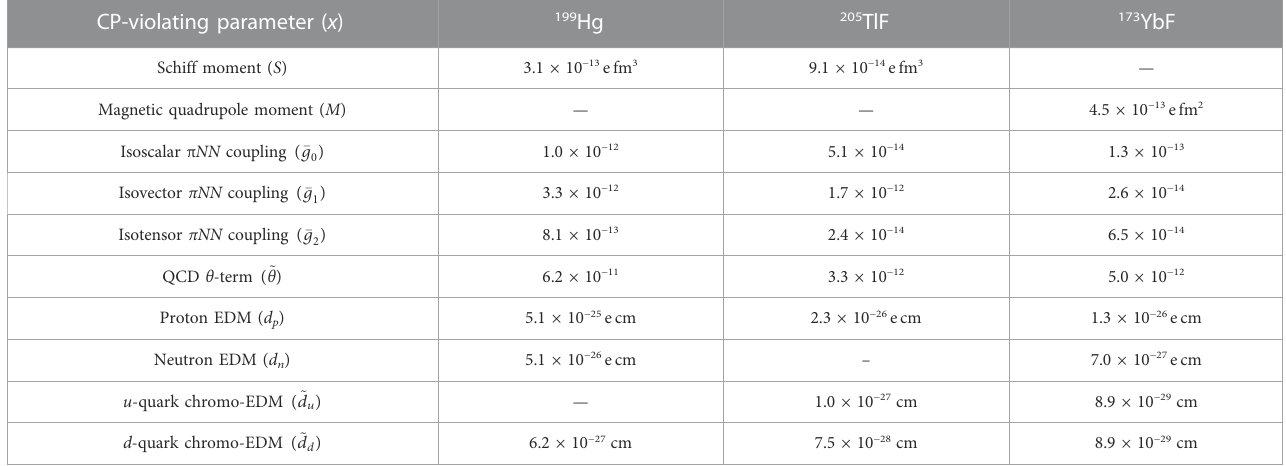
TABLE4Constraints(95%CL)onCP-violatingparameterssetexperimentallyby 199 Hg[14],andprojected2 σ -sensitivitiesfromproposalstomeasurethesein 205 TlF[15] and 173 YbF (this paper). For 199 Hg, the constraints given here differ from those given in [14] because we use the coef fi cients from [36]. CP-violating parameter ( x